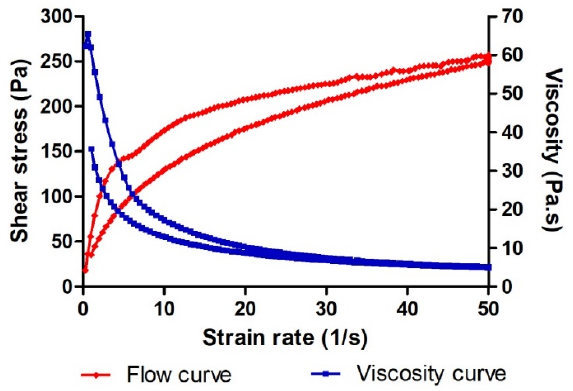
Figure 2. Rheological behavior of AmB+BGEO gel showing a hysteresis loop.